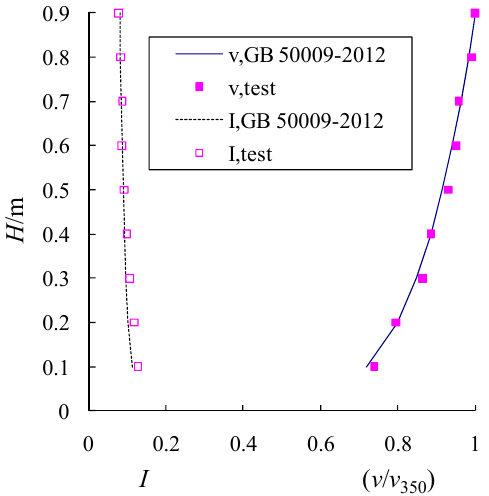
Figure 2. Mean wind velocity and turbulence intensity profiles.